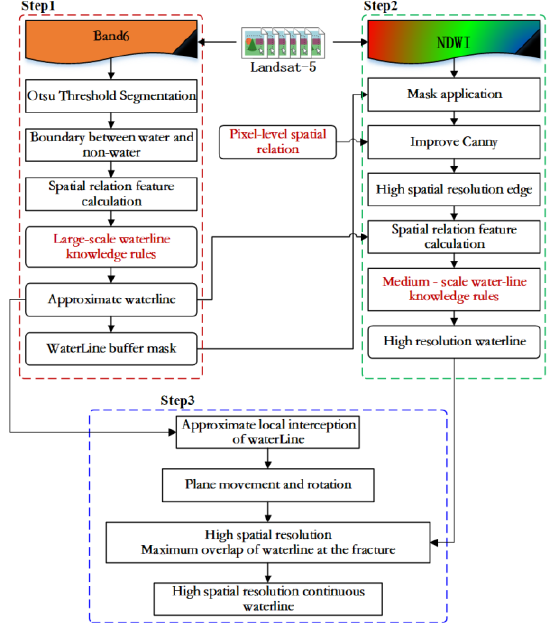
Figure 6. Flow chart of the waterline extraction